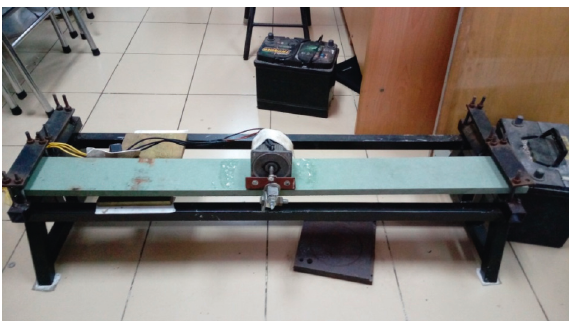
Figure 10: Experimental beams and the cuts.